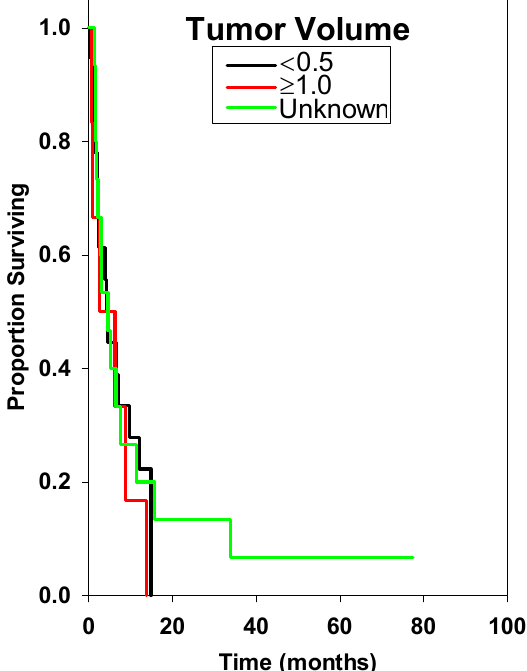
Figure 8. Survival curve comparing tumor volume (<0.5 cc vs. ≥ 1.0 cc). There was no statistically significant difference among these